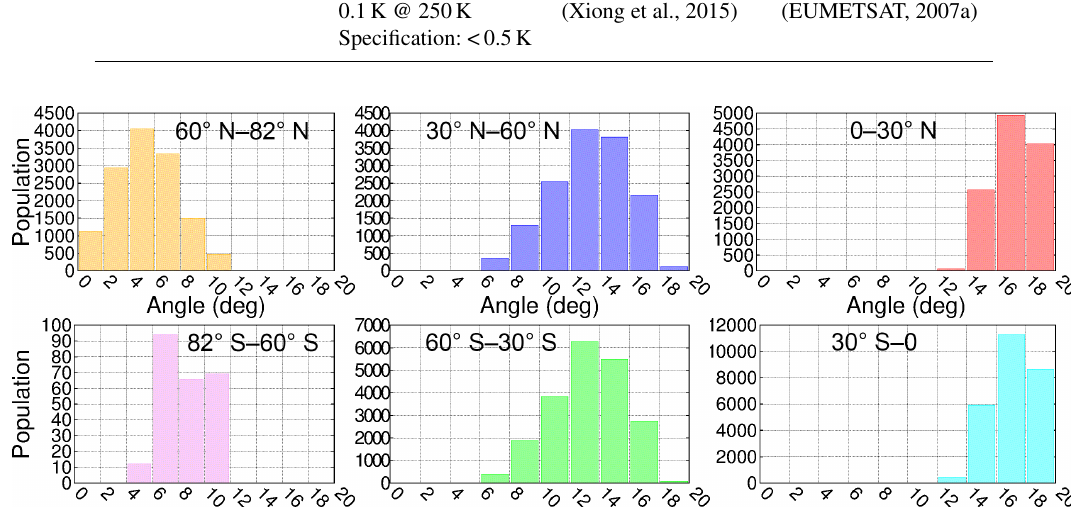
Figure 1. Histograms of MODIS viewing angles for clear sky pixels collocated with the IIR swath over ocean in July 2014. Top row from left to right: 60–82, 30–60, 0–30 ◦ N. Bottom row from left to right: 82–60, 60–30, and 30–0 ◦ S.